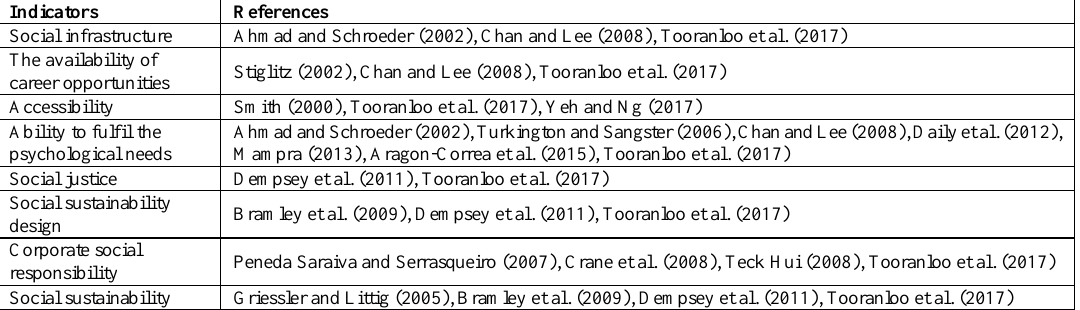
Table 4. Social sustainability indicators of SHRM